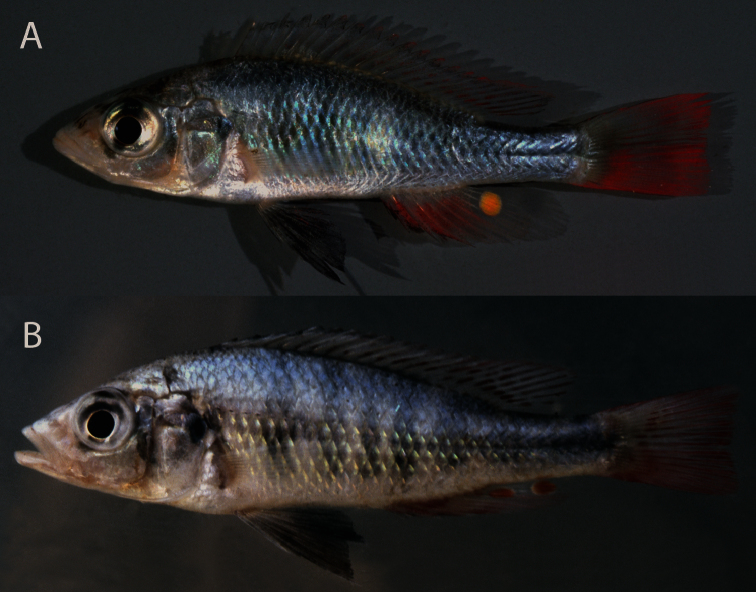
Live colours of Haplochromis argens sp. n. A sexually active ♂, 59.3 mm SL (paratype, RMNH.PISC.83622), Emin Pasha Gulf B sexually active ♂, 72.1 mm SL (paratype, RMNH.PISC.84067), Mwanza Gulf.